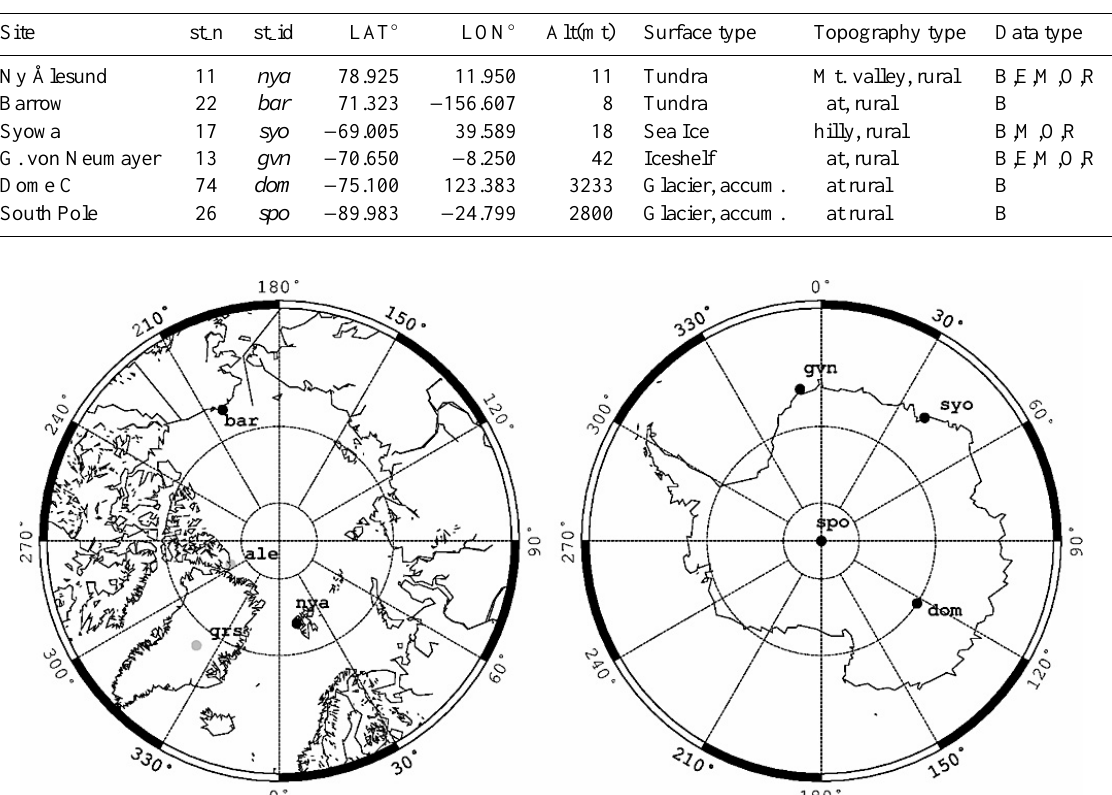
Figure 1. Position of the BSRN-IPY polar station (black), along with BSRN stations in pending status